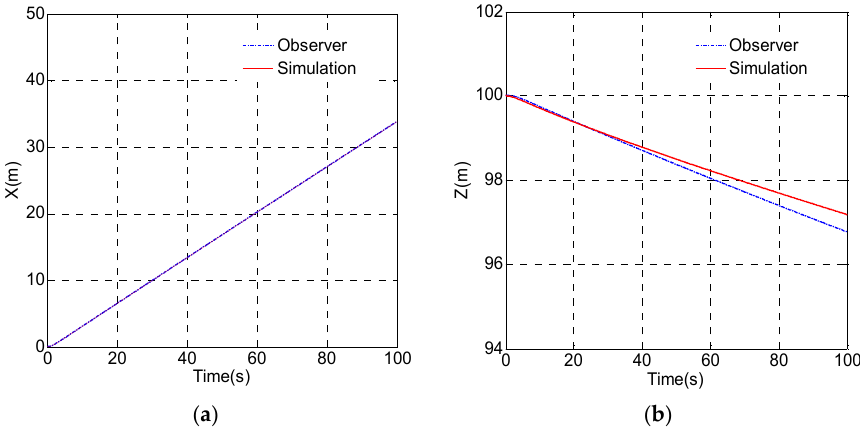
Figure 23. Observed result of ROV position: ( a ) position in the X direction; ( b ) position in the Z direction.